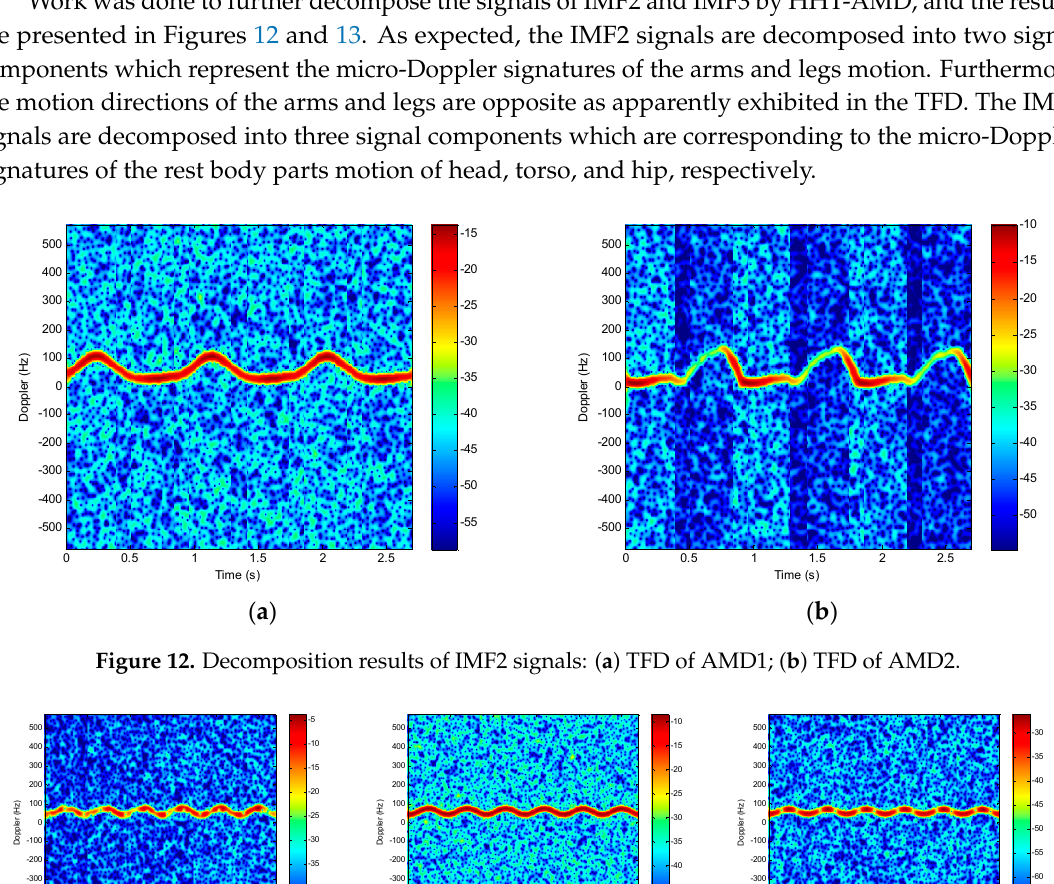
Figure 11. Decomposition results of the HHT: ( a – c ) TFD of IMF1–IMF3.